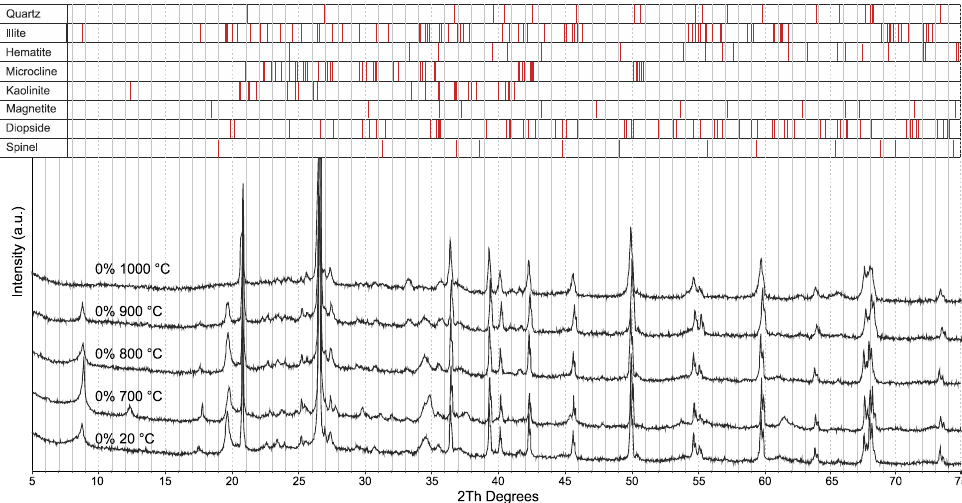
Figure 6. XRD patterns of Liepa clay fired at 700, 800, 900, and 1000 °C (from the bottom to top). Materials 2020 , 13 , 596